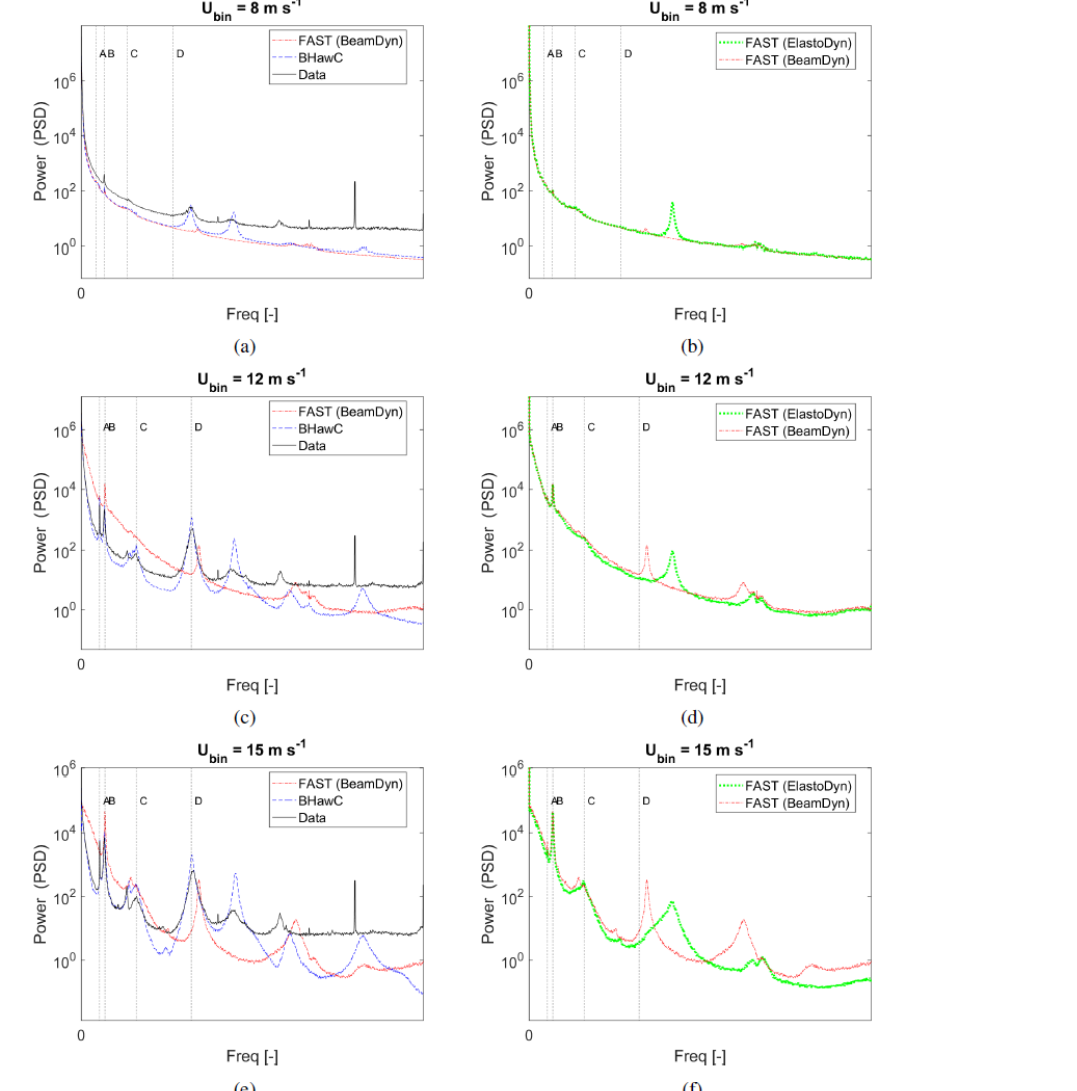
Figure 12. PSDs of the electrical power. The three sets of graphs represent the ensemble-averaged PSDs from the inflow velocity bins at 8ms − 1 (top), 12ms − 1 (center), and 15ms − 1